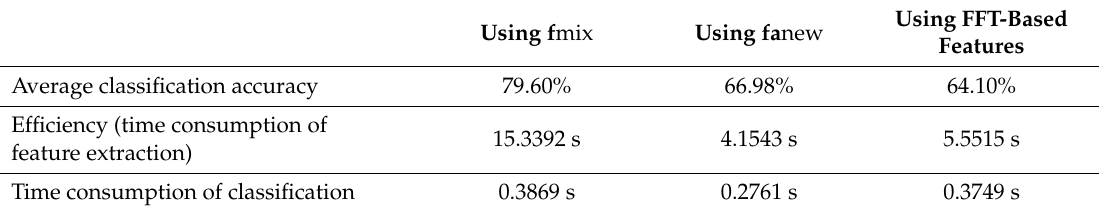
Table 8. Average classification accuracy and time needed for different feature extraction